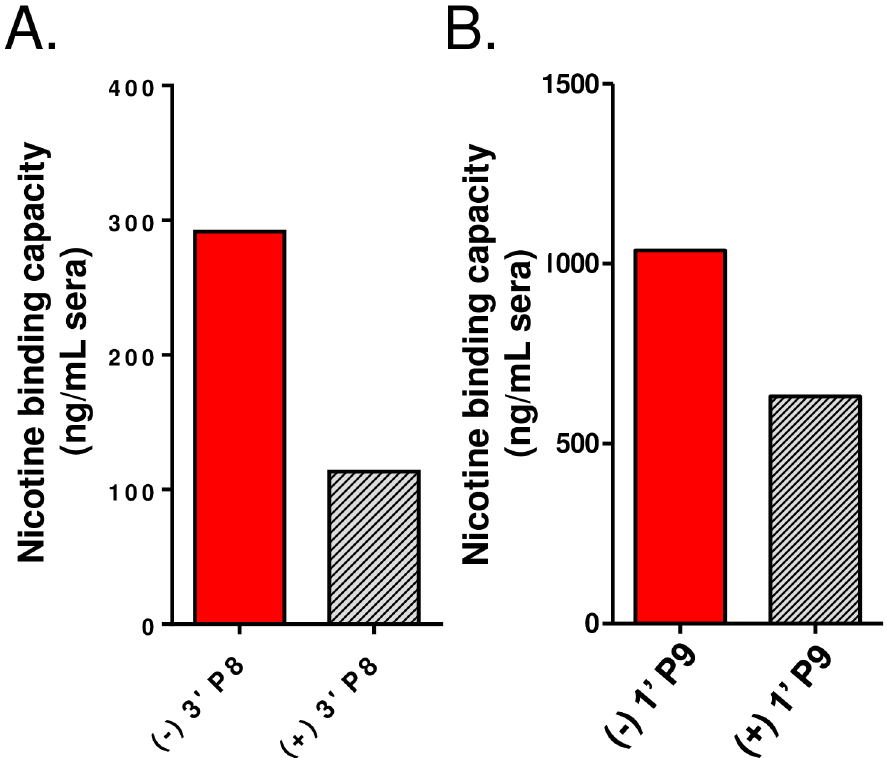
Fig 4. Serum nicotine binding capacities improve when using natural (-) enantiomers of two nicotine haptens. Day 56 serum was collectedand pooledfrom mice immunizedwith 5 µ g (-) 3’ P8 or (+) 3’ P8 (A) or 5 µ g (-) 1’ P9 or (+) 1’ P9 (B). Nicotinebindingcapacitieswere determinedby